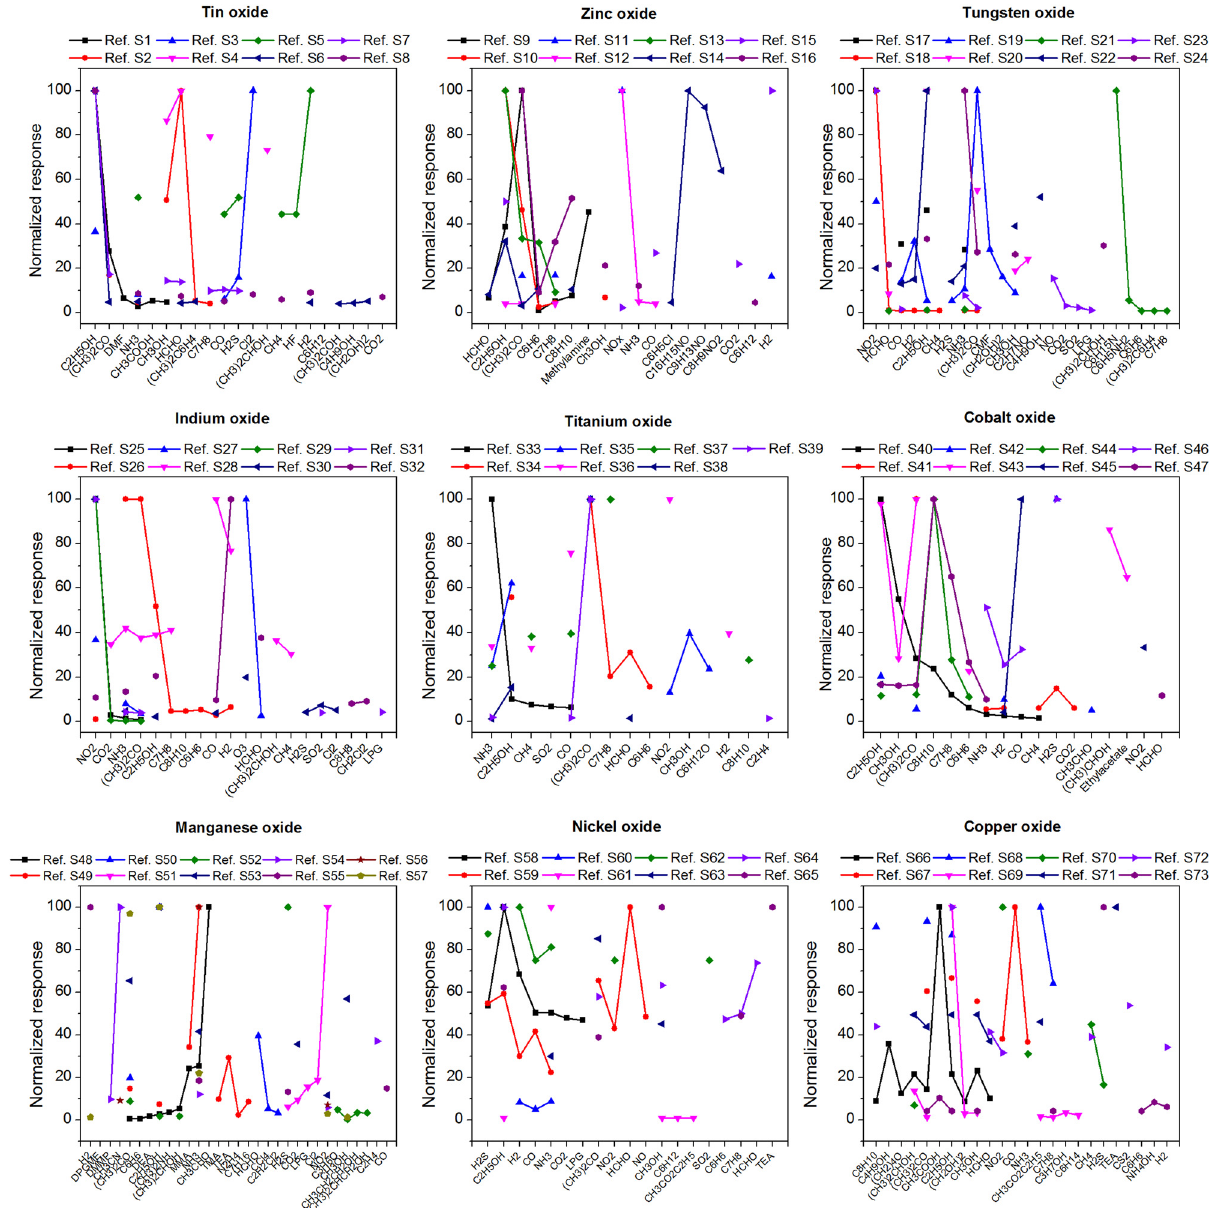
Figure 3: Selectivity of the main metal oxides toward the studied gases. The response in each reference was normalized ( the highest response was set to 100 ) . The references from which the data are taken are given in the Supplementary